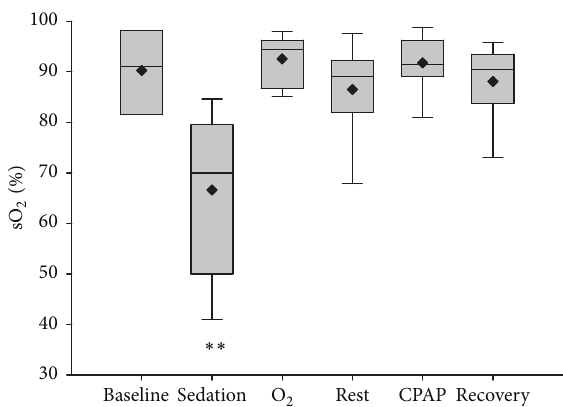
Figure 1: Haemaglobin saturation determined by pulse oximetry following sedation and respiratory support by oxygen insufflation or continuous positive airway pressure (CPAP). Values are shown as median (horizontal line), mean (diamond), quartiles, and range immediately after catheter placement (T0, baseline), 10 minutes following sedation (T1, sedation), following 10 minutes of oxygen supplementation (O 2 ), following 10 minutes of CPAP, and after 10 minutes of breathing ambient air following respiratory support (T3, rest, and T5, recovery). Order of respiratory support (O 2 supplementation or CPAP) was randomly assigned to replicate groups of paired calves and administered at T2 (5 calves) or T4 (5 calves); treatment order had no significant effect on response to O 2 supplementation or CPAP. Values obtained following sedation were significantly less than at all other times ( ∗∗ 𝑃 < 0.001 ).